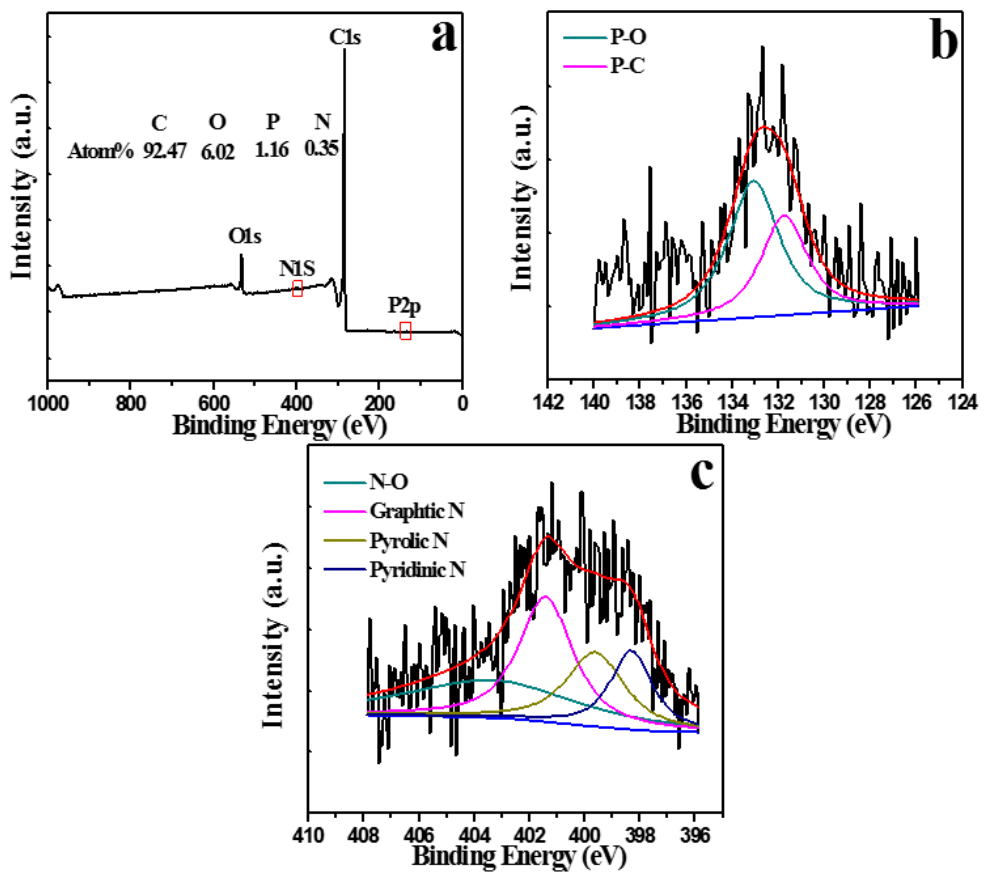
Figure 4. X-ray photoelectron spectroscopy (XPS) survey ( a ) and high resolution P2p ( b ), and N1s ( c ) spectra of